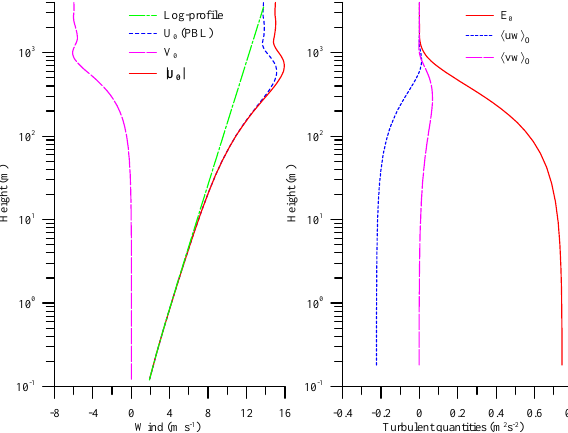
Figure 1. Initial input profiles of U 0 , V 0 , | U 0 | , E 0 , h uw i 0 and h vw i 0 , which is the results of the 1-D PBL model runs of (Weng and Taylor , 2003) for the given condition of z 0 = 0 . 03 m, f = 10 − 4 s − 1 , ( U g ,V g ) = (13 . 77 , − 5 . 95) m s − 1 , neutral thermal stratification. Logarithmic wind profile for the surface layer model is also inclcuded.